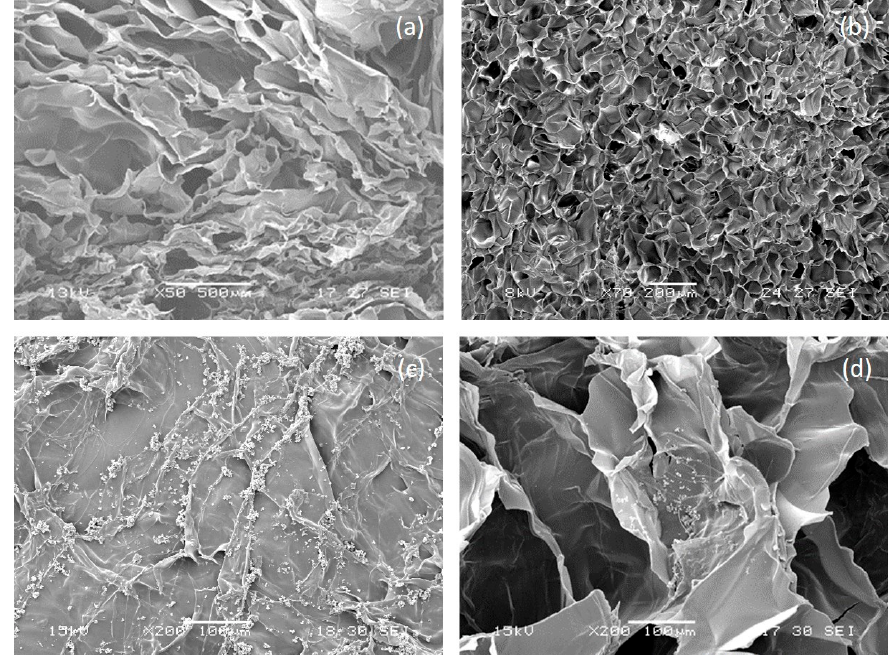
Figure 3. Morphological analysis of alginate / gelatin / elastin (AGE) sponges. Section and surface of not-functionalized AGE sponge are shown in ( a , b ), respectively; section and surface of MIP-functionalized AGE sponge are shown in ( c , d ),